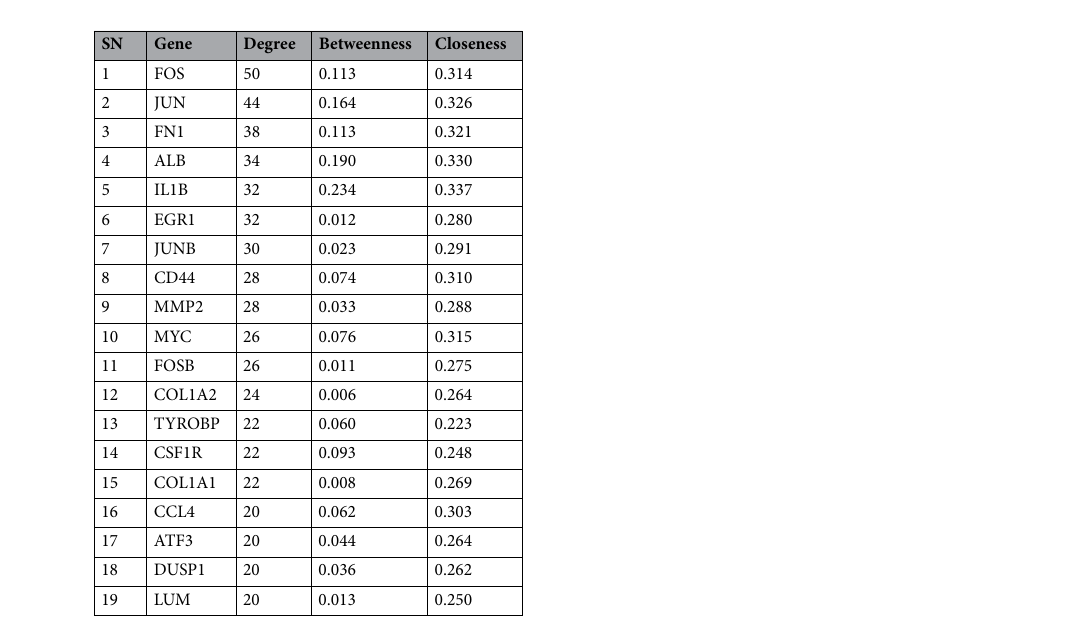
Table 3. List of 19 hub genes which were identified from PPI network based on degree of connectivity.